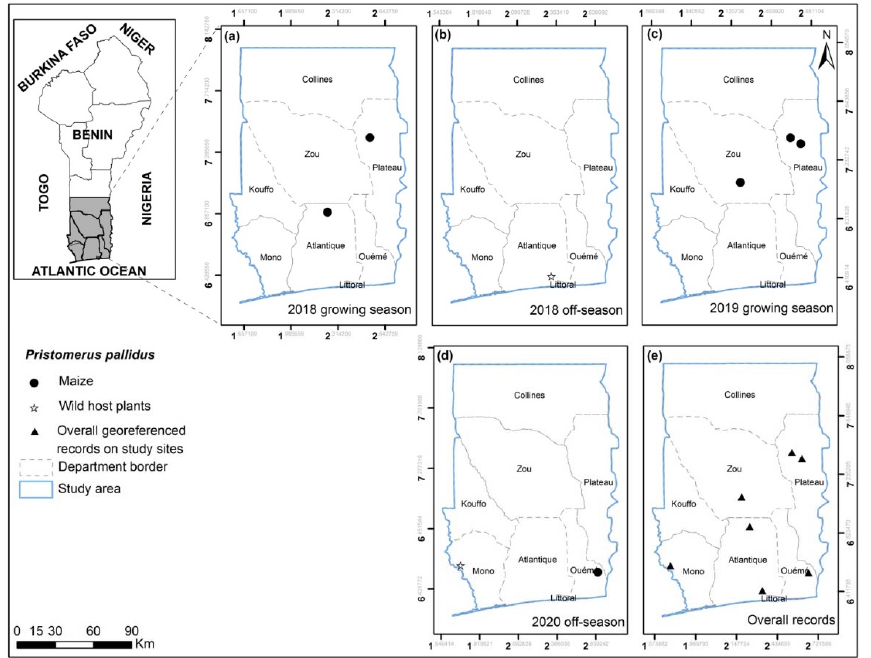
Figure 8. Pristomerus pallidus georeferenced records on maize, wild and other cultivated host plants for the years 2018, 2019 and 2020 on the study sites for growing ( a , c ) and off-seasons ( b , d ) in southern and central Benin ( e ). No P. pallidus were found in the 2019 off-season.